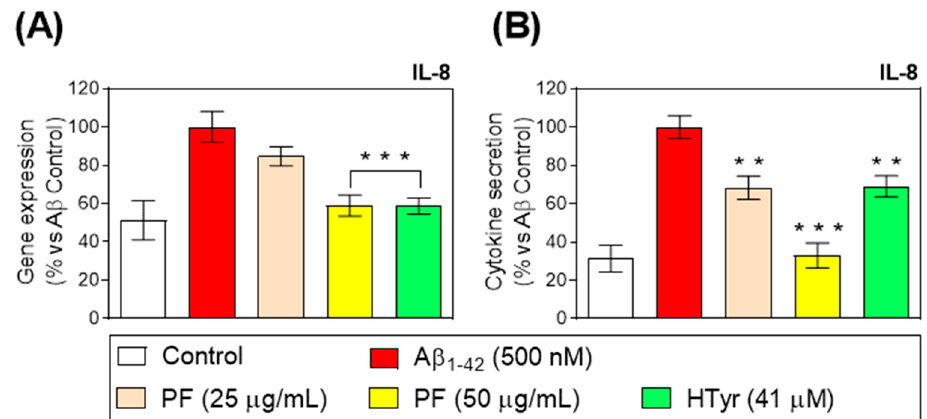
Figure 3. ( A ) Relative gene expression and ( B ) release of IL-8 in A β 1-42 -stimulated primary human neutrophils after treatment with the PF from VOO (25 and 50 µg/mL) or hydroxytyrosol (HTyr, 41 µM) for 6 h. Values are means of the three independent experiments in triplicate, with their standard errors represented by vertical bars (** p < 0.01; *** p < 0.001 vs. A β 1-42 -treated cells).